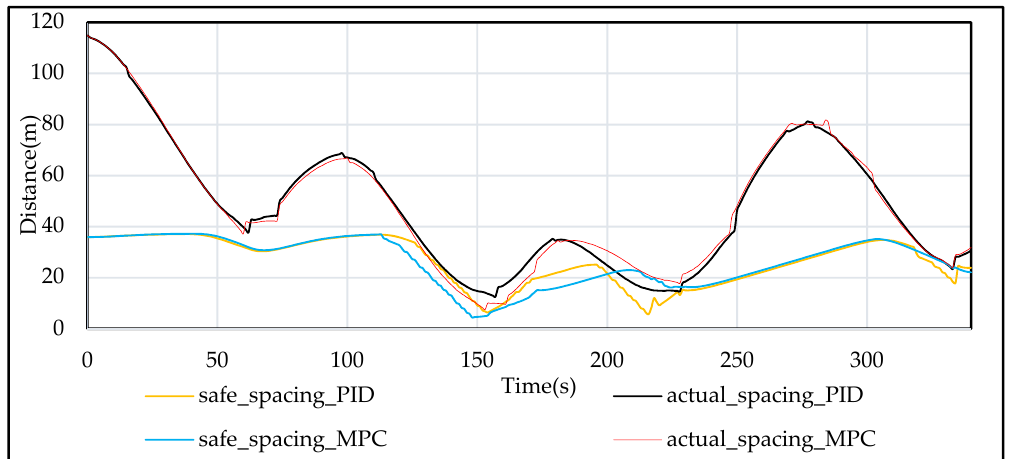
Figure 9. Spacing response in scenario 1 . Table 2. Emissions results in Scenario 1.